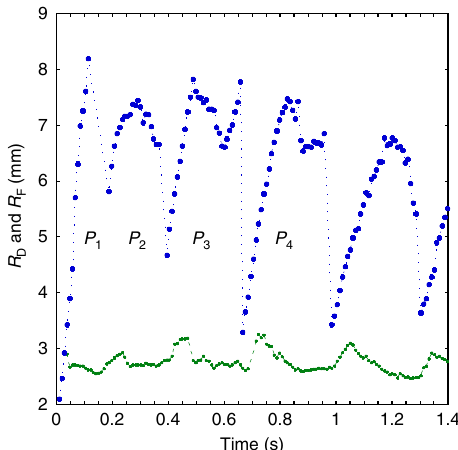
Fig. 4 Two rings of droplets coexist for some time just before the fi lm recoils during pulsation P 3 . The inner ring, with droplets ~35 µ m in diameter, occurs shortly after the expanding rim broke up. a General view; b magni fi cation of the framed area; scale bars = 1